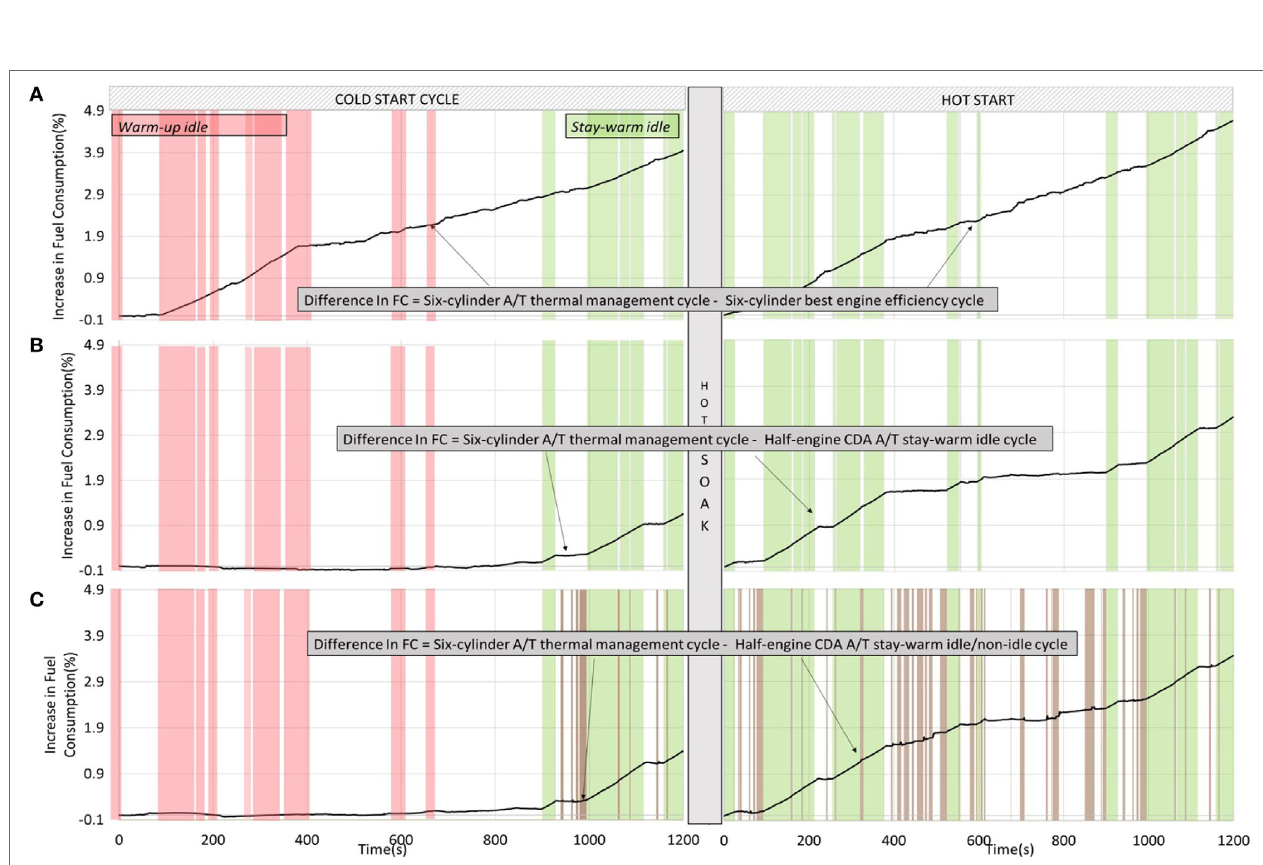
FigUre 18 | (a) Delayed fuel injections and maximally/mostly closed VGT positions results in higher fuel consumption for the “Six-cylinder A/T thermal management cycle” compared to the “Six-cylinder best engine efficiency cycle.” (B) The more efficient Half-engine CDA operation during the stay-warm idle sections of the “Half-engine CDA A/T stay-warm idle cycle” result in fuel consumption reductions during those periods relative to the fuel consumption during the “Six-cylinder A/T thermal management cycle.” (c) “Half-engine CDA stay-warm idle/non-idle cycle” can be seen to have lower fuel consumption than “Six-cylinder A/T thermal management cycle” during both idle and non-idle